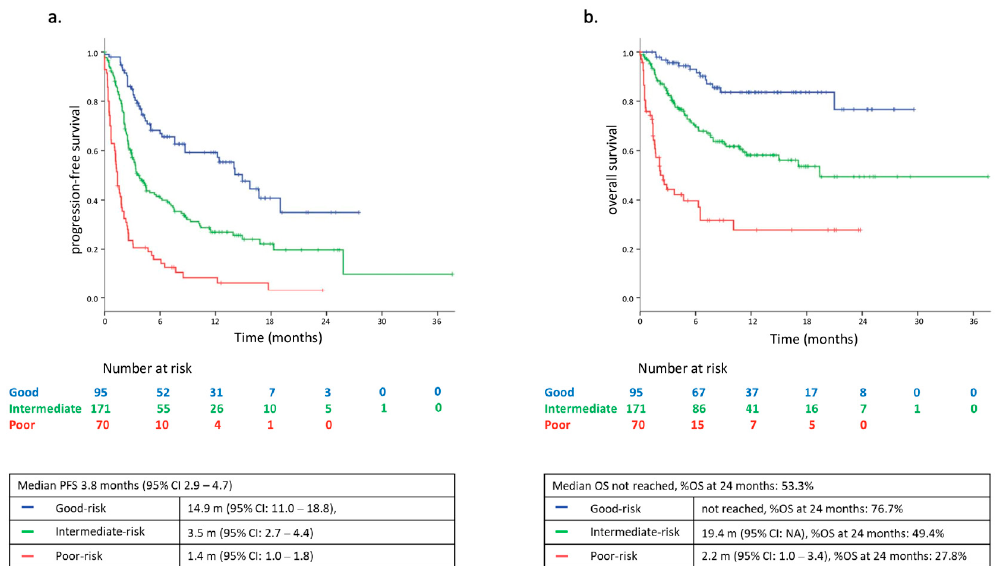
Figure 1. ( a ) Progression free survival (PFS) according to the three risk-groups of the FP prognostic-score model in the study population (N = 336); ( b ) overall survival (OS) according to the three risk-groups of the FP prognostic-score model in the study population ( n =